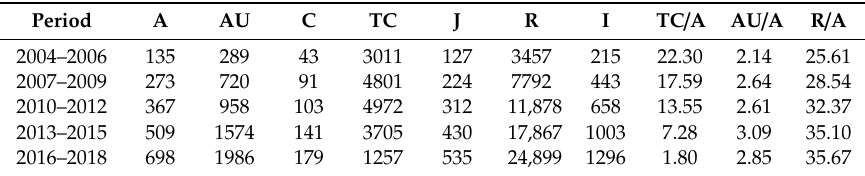
Table 2. Major characteristics of the articles of the impact of the university classroom on managing the socio-educational well-being (2004–2018).